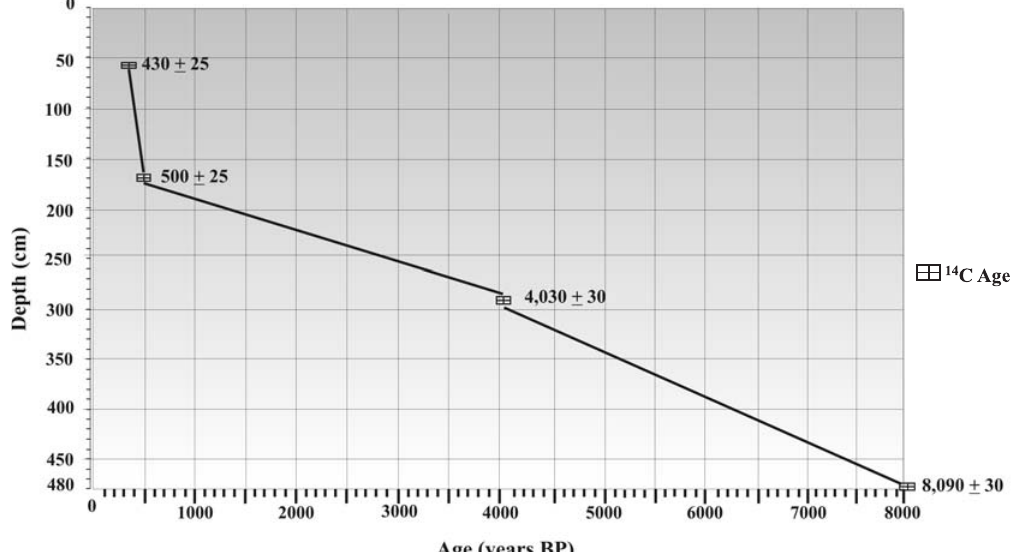
Figure 3. Determined and interpolated 14 C ages of layers of the peatland profile from